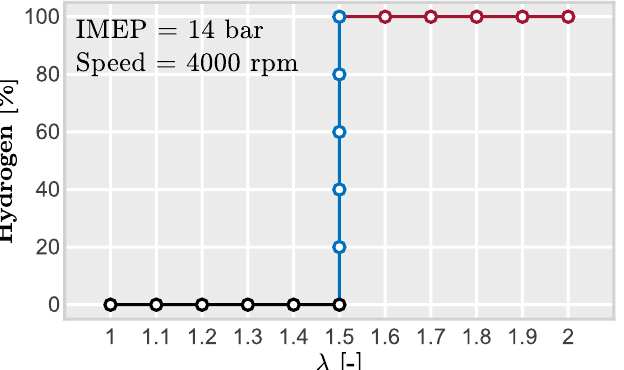
Figure 1. Simulations plan. The black line corresponds with the CNG simulation plan, sweeping the air dilution until λ = 1.5. The blue line sweeps the amount of hydrogen in the fuel from 0% to 100%. The red line considers pure hydrogen combustion varying λ from 1.5 to 2.